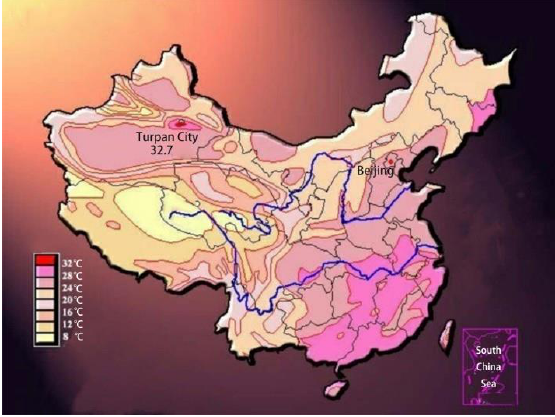
Figure 3. Average temperature map of China in July 2017.